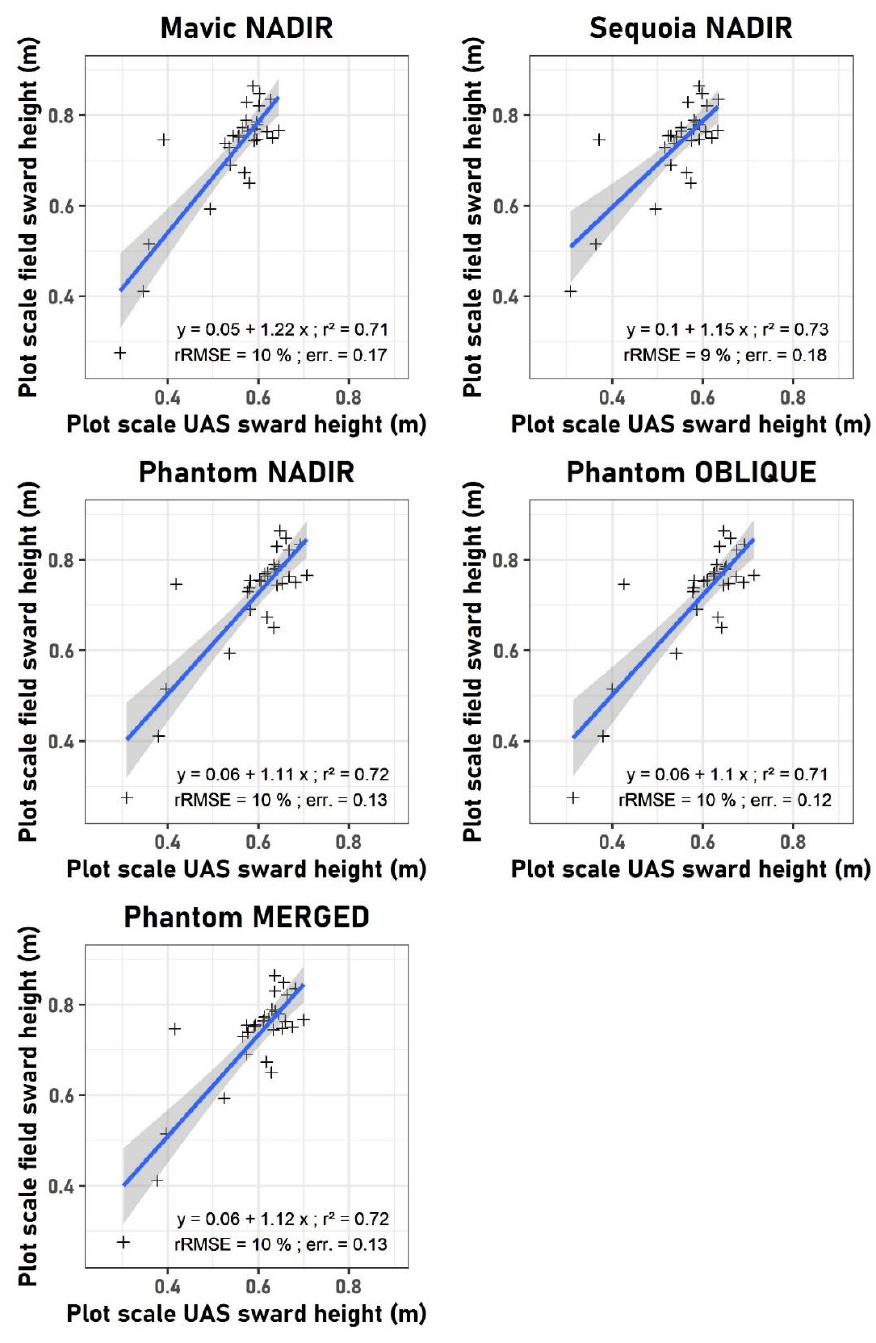
Figure 4. Biplots of the mean UAS sward height and field measurements. The mean error (err.) is computed from the difference between the reference mean field sward height and the mean UAS sward height. Relative root mean square error (rRMSE) is computed from the RMSE ratio with the mean of the mean plot sward height measurements. The blue line is the regression line. The grey area around the regression line represents the 95% confidence region.